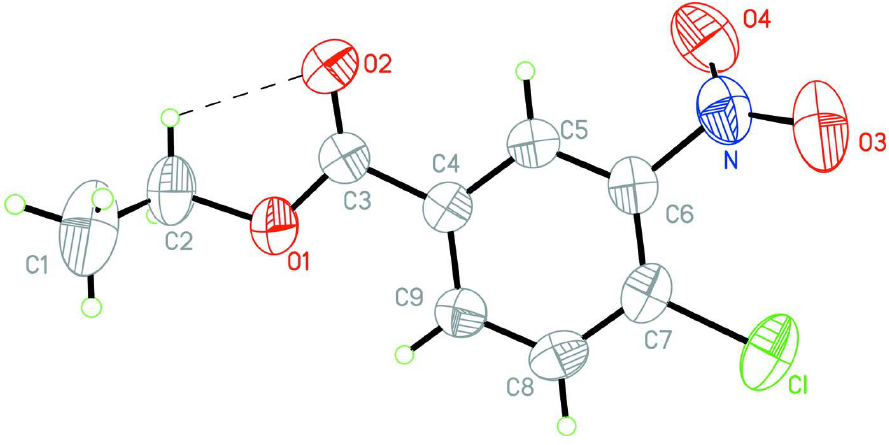
Figure 1 The molecular structure of the title molecule, with the atom-numbering scheme. Displacement ellipsoids are drawn at the 30% probability level.